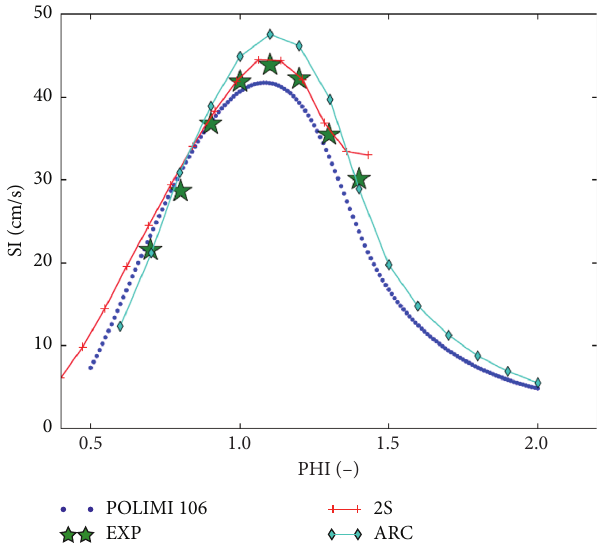
Figure 1: Comparison of laminar flame speed between experi- mental data from [25] (green stars) and numerical simulations